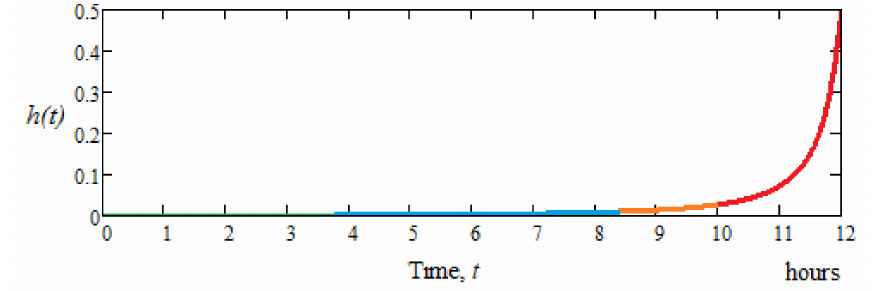
Figure 10. Graph of the instantaneous risk of defecting (defecting probability), h(t) , for the set of dental cutters